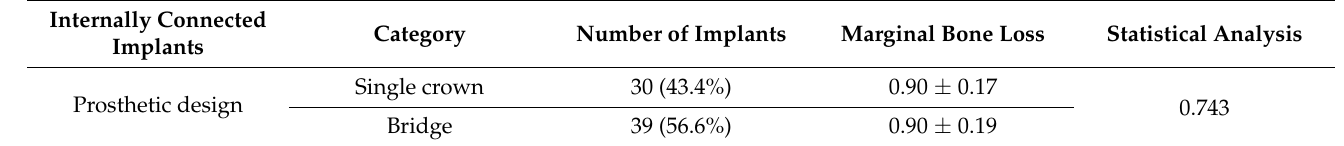
Table 3. Category, number of implants, marginal bone loss, and statistical analysis concerning internally connected implants divided according to prosthetic